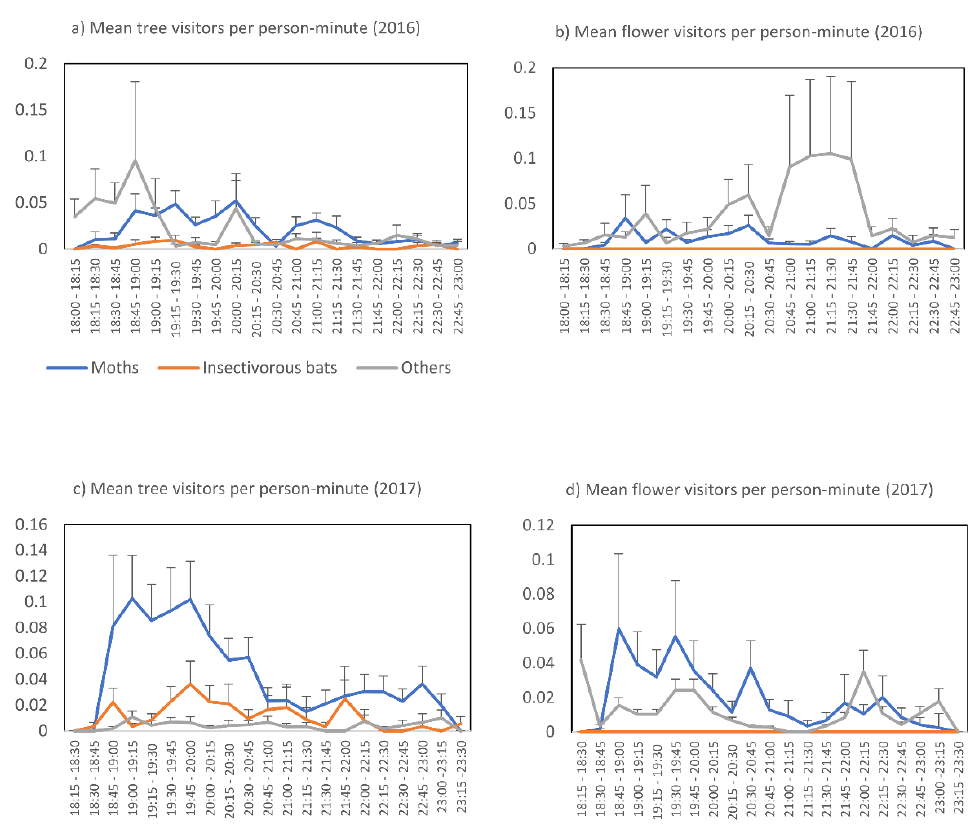
Figure 3. Mean (+ standard error) number of tree visitors ( a , c ) and flower visitors ( b , d ) of baobab trees monitored by citizen scientists in South Africa and Zimbabwe during the flowering season (November–December) during 2016 ( a , b ) and 2019 ( c , d ). For presentation, data points for fruit bat visitors not shown (see Results).